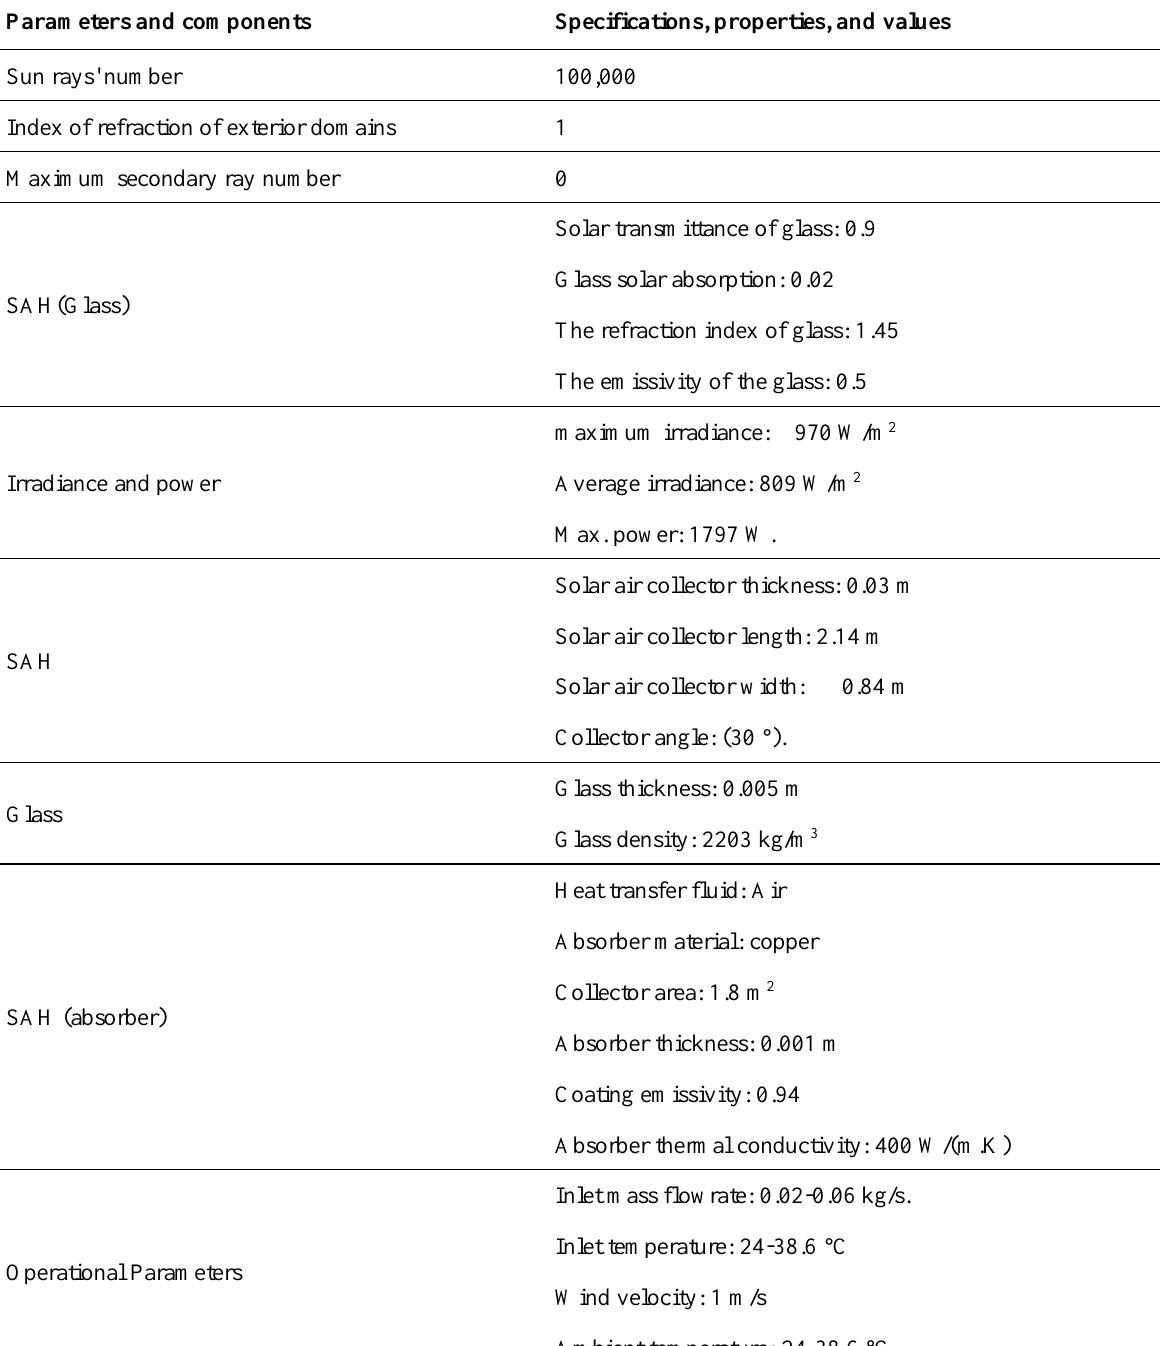
Table 1 . Thermal and Optic Geometric Properties of Solar Air Heaters. Parameters and